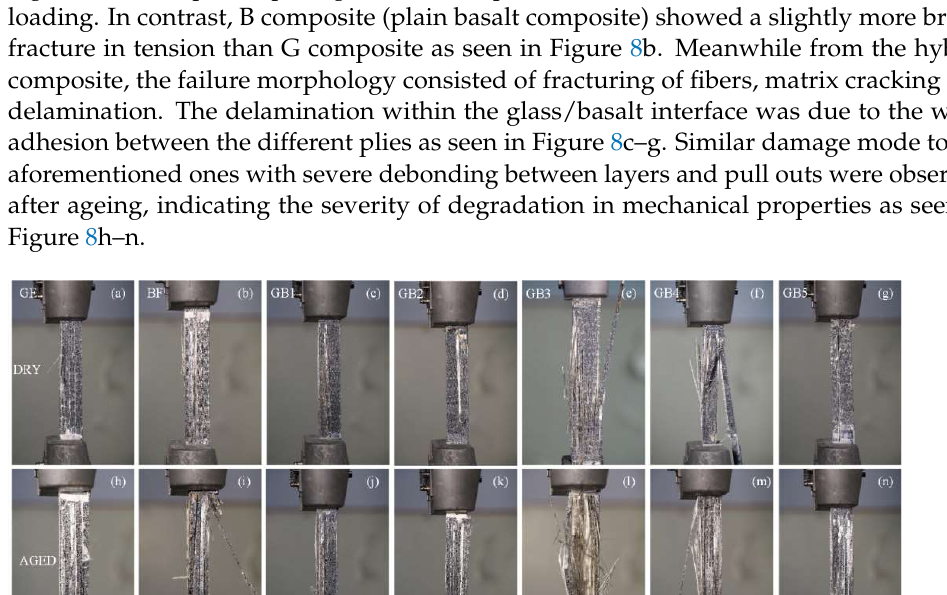
Figure 9. SEM images of tensile specimens in dry condition ( a ) GF ( b ) BF ( c ) GB1 ( d ) GB2 ( e ) GB3 ( f ) GB4 ( g ) GB5.